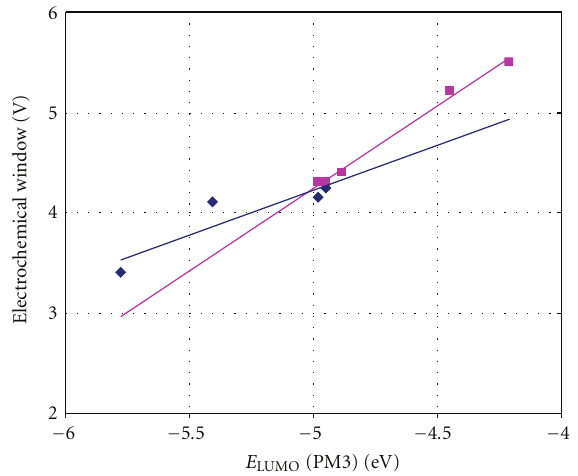
Figure 6: Plot of calculated E LUMO (PM3) of the cation versus electrochemical window of the ionic liquid: blue: anion BF 4 − ; pink: anion (CF 3 SO 2 ) 2 N − . The correlation coe ffi cients are 0.91 (anion = BF 4 − ) and 0.99 (anion = (CF 3 SO 2 ) 2 N −